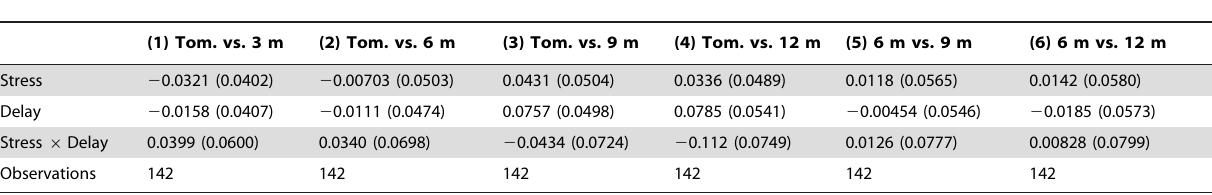
Table 8. Effect of stress manipulation on patient responding in intertemporal choice task.